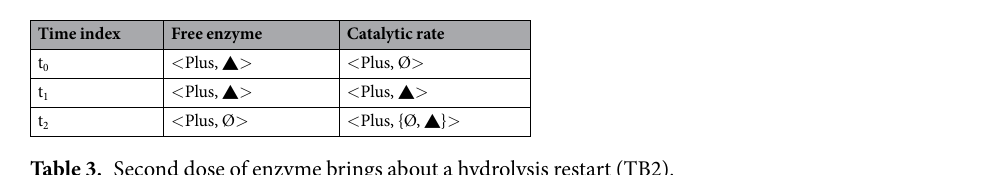
Table 3. Second dose of enzyme brings about a hydrolysis restart (TB2).